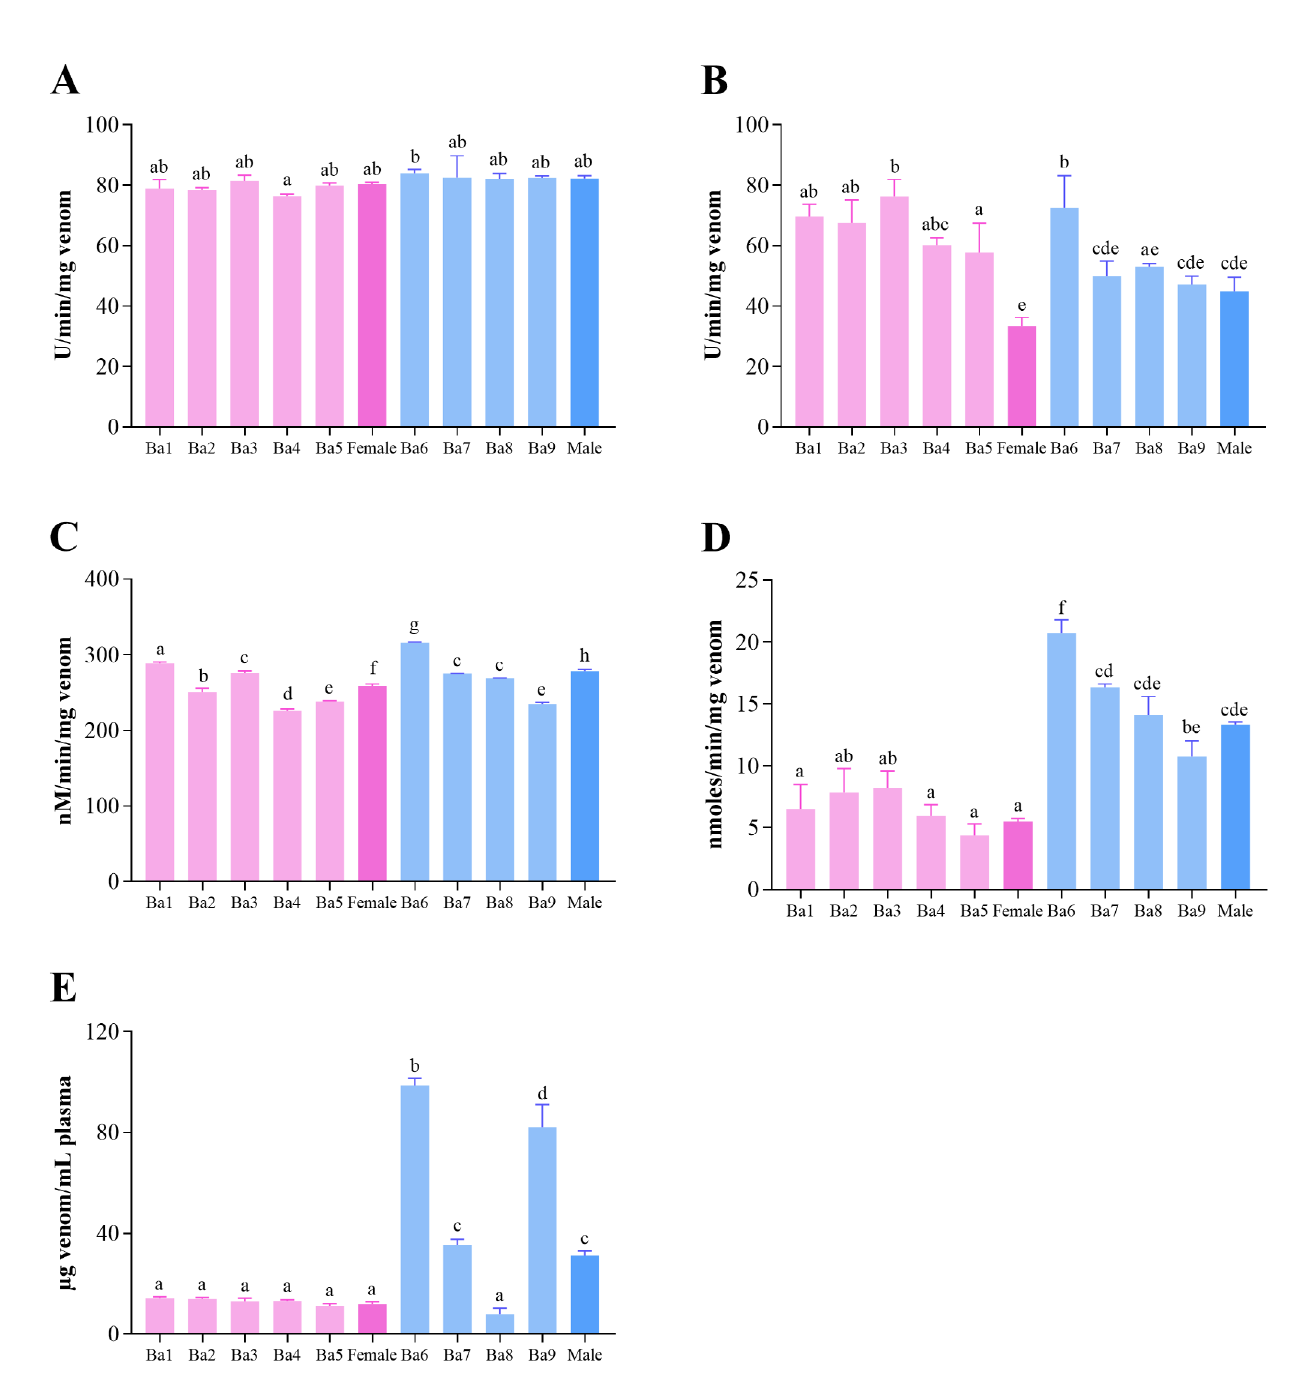
Figure 3. Enzymatic activities of B. atrox venom (individual and pool). The data were expressed as mean ± SD, n = 3. Different letters indicate statistical difference (ANOVA, p < 0.05). (A) Caseinolytic activity; (B) collagenolytic activity; (C) LAAO activity; (D) PLA